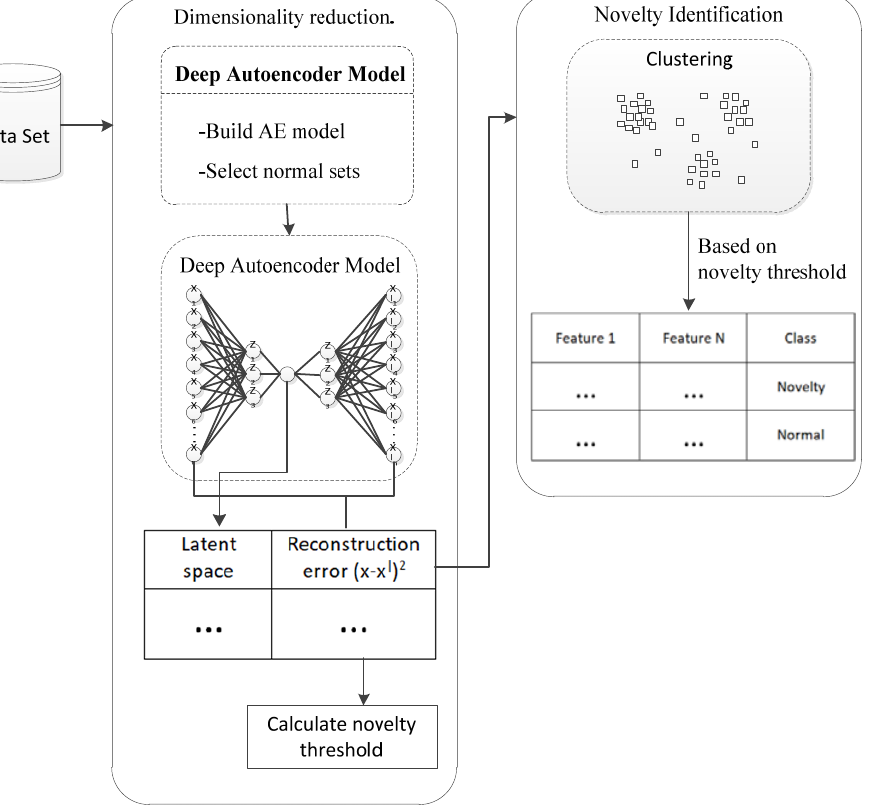
Figure 1. General architecture of proposed method.